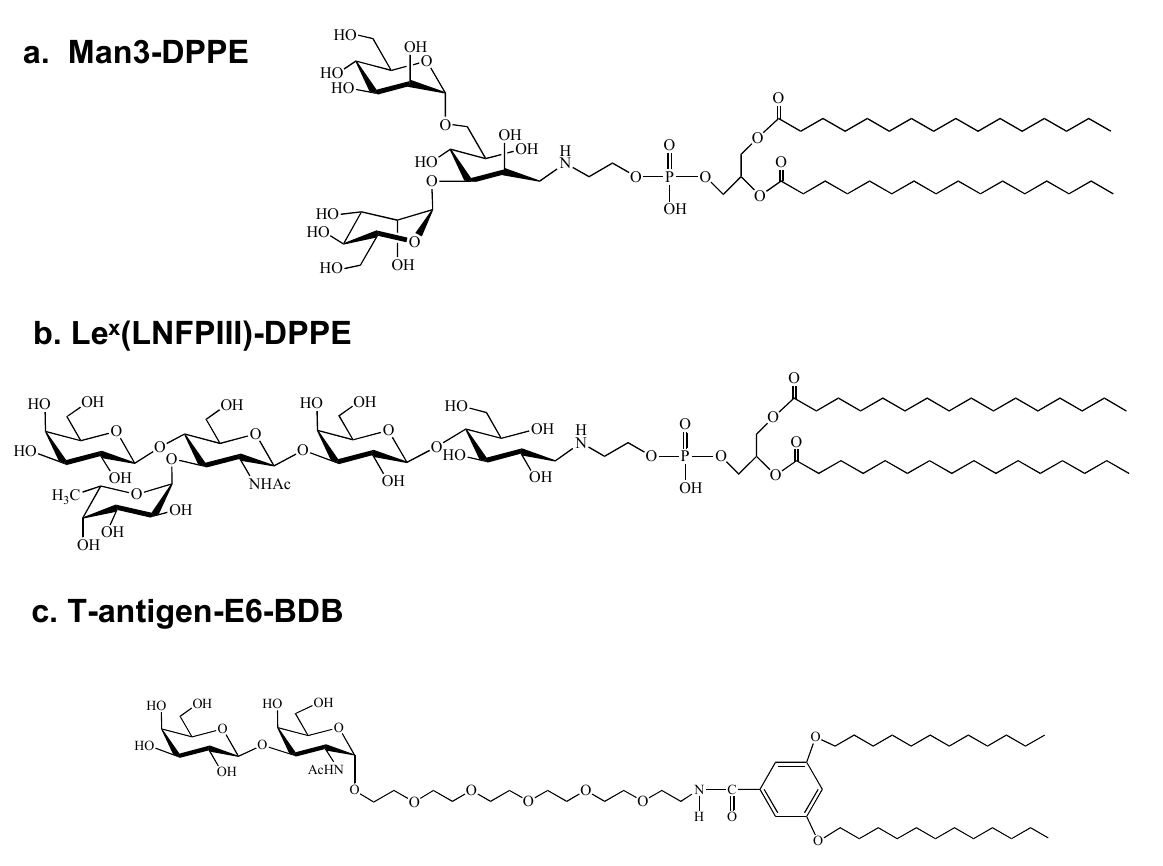
Figure 1. Carbohydrate probes used for the panning and screening of phages displaying human single-chain variable-fragments (scFvs) proteins by various structurally-defined carbohydrate probes: ( a ) mannotriose-dipalmitoylphosphatidylethanolamine (Man3-DPPE); ( b ) Le X (lacto-N-fucopentaose III (LNFPIII))-DPPE; and ( c ) T-antigen E6-3,5-bis-8- dodecyloxy benzamide